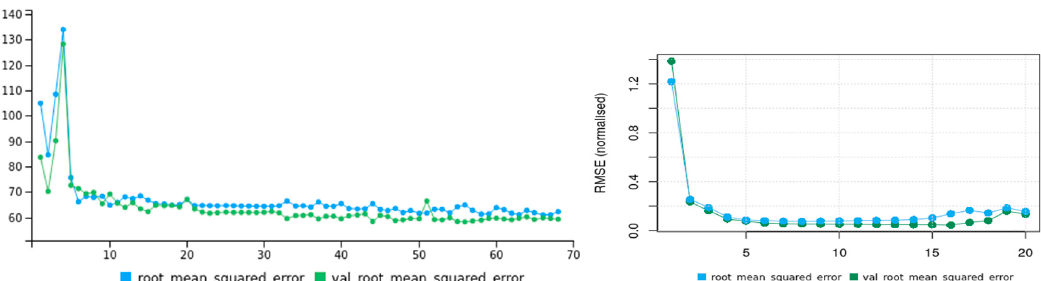
Figure 3. Example of two training attempts of machine learning models from Group 3 that use the validation dataset as support information for early stopping. The x-axis represents training epochs. On the left, a training attempt of the long short-term memory (LSTM) model (y-axis indicates absolute root mean squared error (RMSE) values), and on the right, a training attempt of the non-linear autoregressive neural networks (NARX) model (y-axis indicates normalised RMSE values), both for one month lead-time forecasting at the Guavio